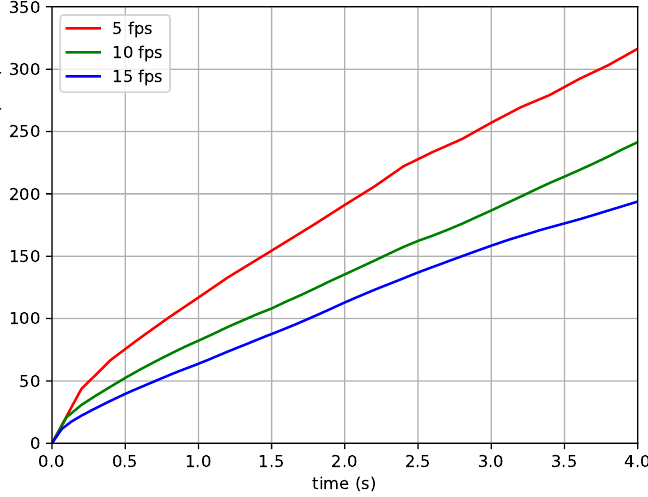
Figure 6. Vertex errors on training and test data acquired using different sampling rates. The numbers in the graph represent the vertex error over